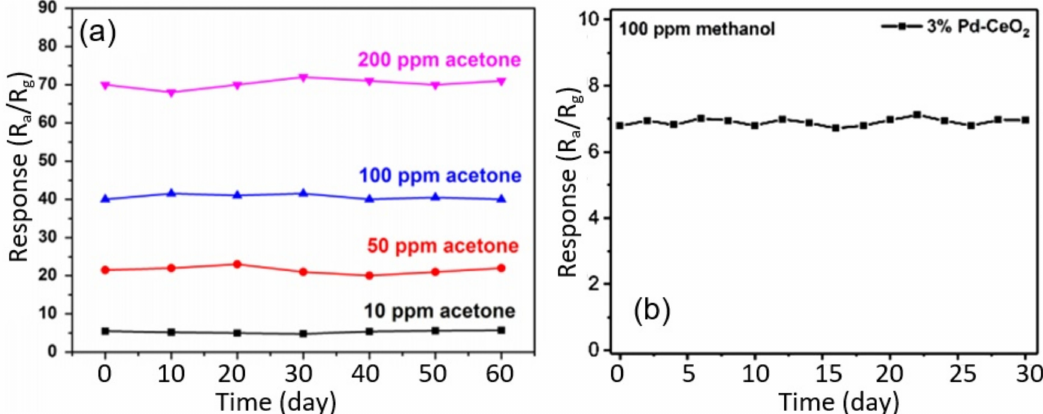
Figure 25. ( a ) Long-term stability of gas sensor based on 4 at.% Ce-doped α -Fe 2 O 3 nanotubes to 10, 50, 100 and 200 ppm acetone at 240 ◦ C. ( b ) Stability test of the 3% Pd-CeO 2 nanofiber-based sensor to 100 ppm methanol at 200 ◦ C. ( a ) Reprinted with permission from [340]. Copyright 2014 Elsevier; ( b ) Reprinted with permission from [195]. Copyright 2020 Elsevier.